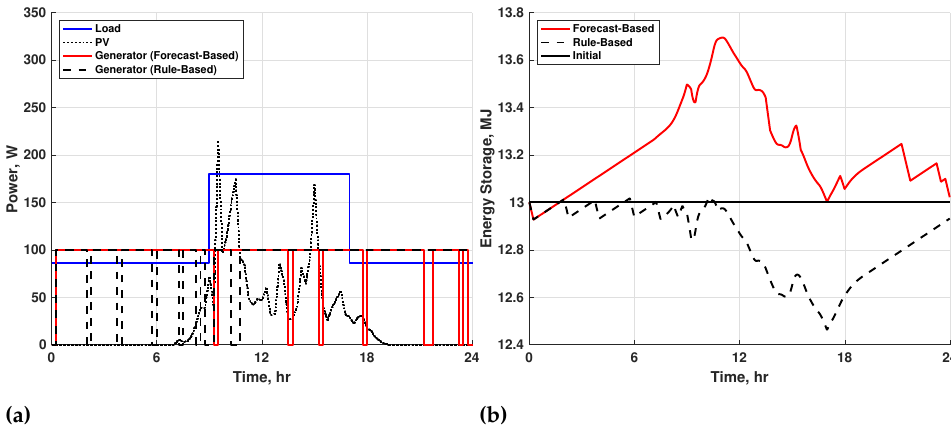
Figure 6. Stress case 1 power ( a ) and energy storage ( b ).